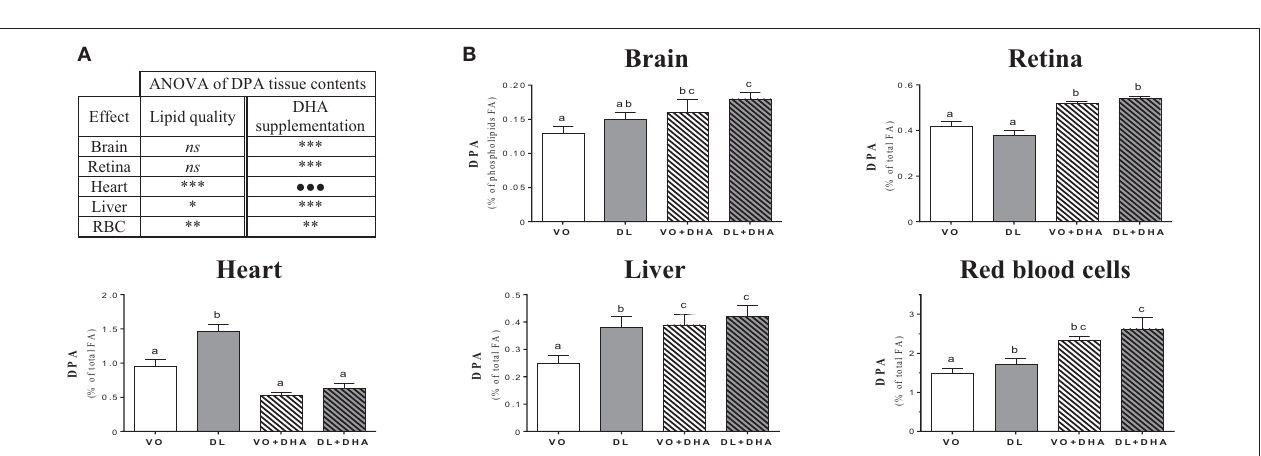
FIGURE 3 | (A) Overall lipid quality (LQ) effect and DHA supplementation (S) effect of the docosahexaenoic acid (DHA) proportions in brain, retina, heart, liver and red blood cells (RBC) of rats fed the vegetable oil blend diet (VO) or the vegetable oil and dairy lipid blend diet (DL); not supplemented or supplemented with 0.5% DHA (VO + DHA and DL + DHA). The significance of the two effects was assessed by two-ways ANOVA (* p < 0.05, ** p < 0.01, *** p < 0.001). *Represents globally an increase in favor of the DL groups for the LQ effect, and in favor of the lots supplemented with DHA for the S effect. ns, not significant. (B) Proportions of DHA in tissues. Values are mean ± SEM. Different superscript letters indicate significant differences for multiple comparisons ( p < 0.05).